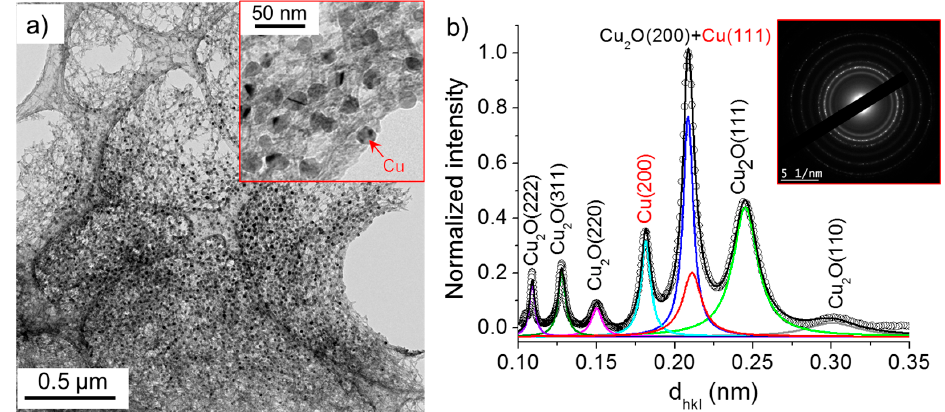
Figure 9. ( a ) TEM images of nanowires and nanoparticles synthesized in deionized water ( σ 0 = 2 µS/cm) and ( b ) the corresponding SAED pattern (performed on the insert in ( a )) radially integrated spectrum.